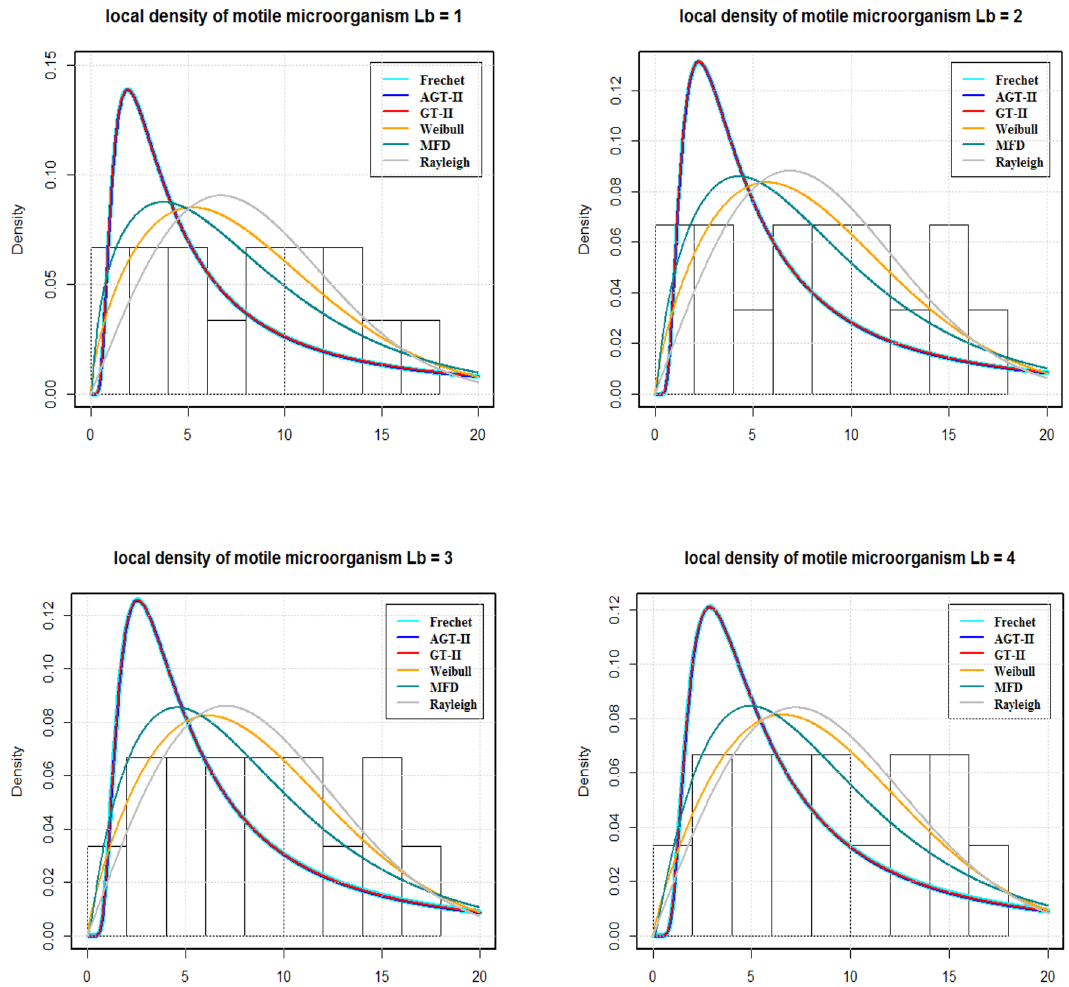
Figure 6. The estimated densities for the